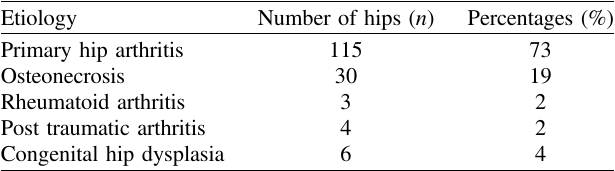
Table 1. Etiology of